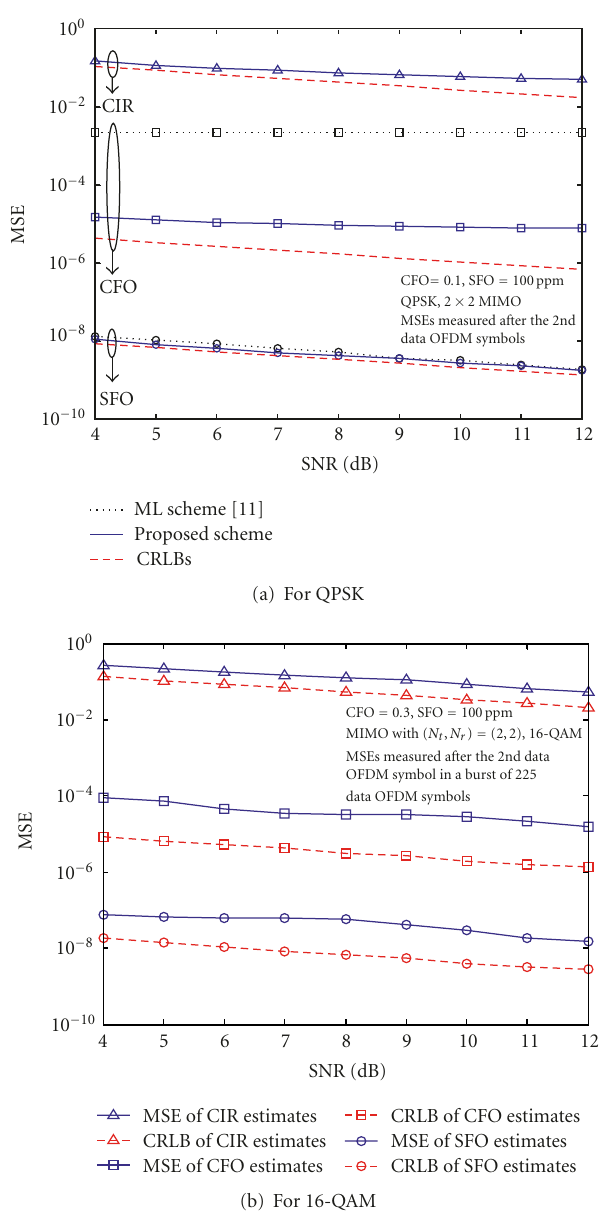
Figure 7: MSE and CRLB of CIR, CFO, and SFO estimates versus SNR.